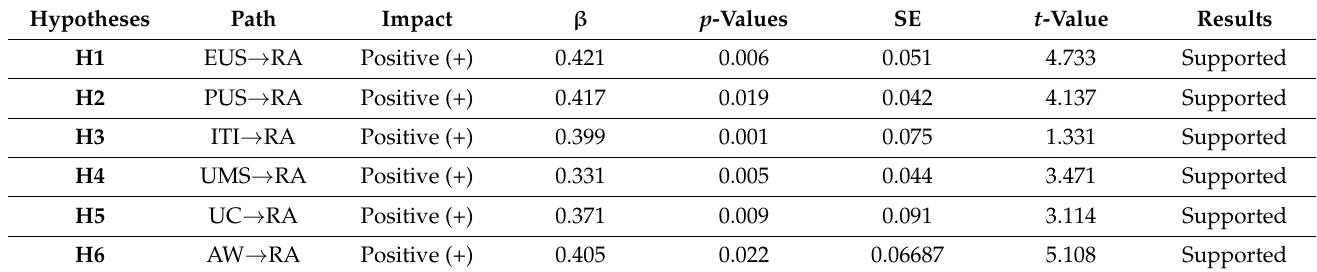
Table 4. Results of Structural Equation Modelling